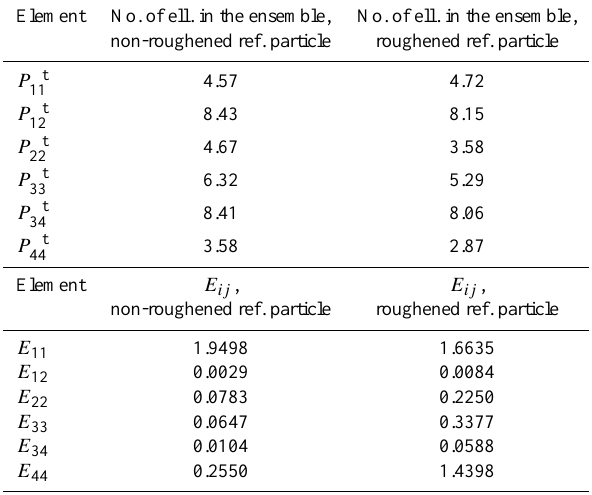
Table 1. Number of ellipsoids employed in the fits, and the scatter- ing errors. The numbers shown are means across all 40 refractive indices and four individual particles plus the three-particle ensem- ble. An ellipsoid is counted as part of the ensemble when its relative weight is at least